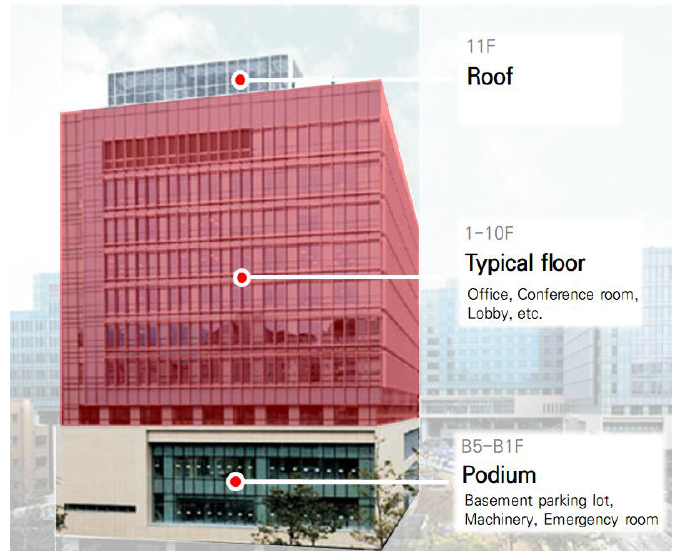
Figure 8. Front view of R&D center.